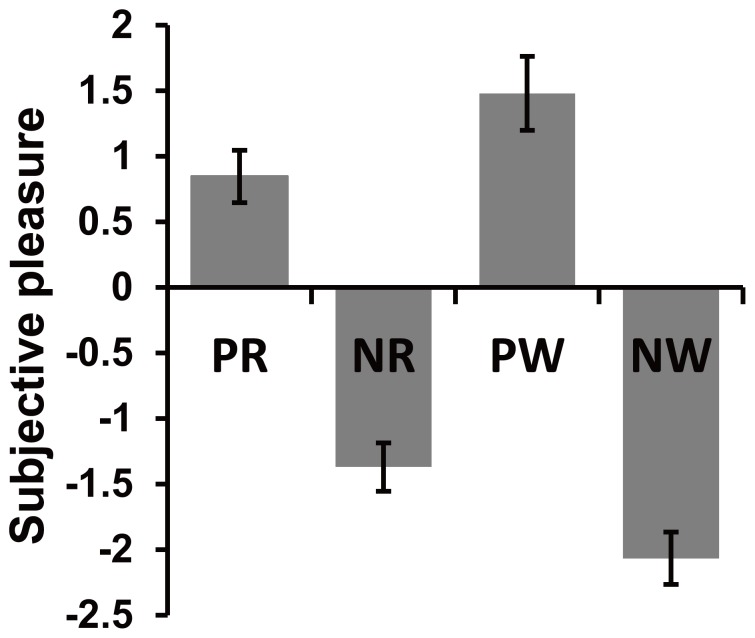
Behavioral results showing the effect of judgment manipulation.Subjective rating regarding the pleasure for four types of judgments (mean ± SEM) was modulated by the valence of judgment.